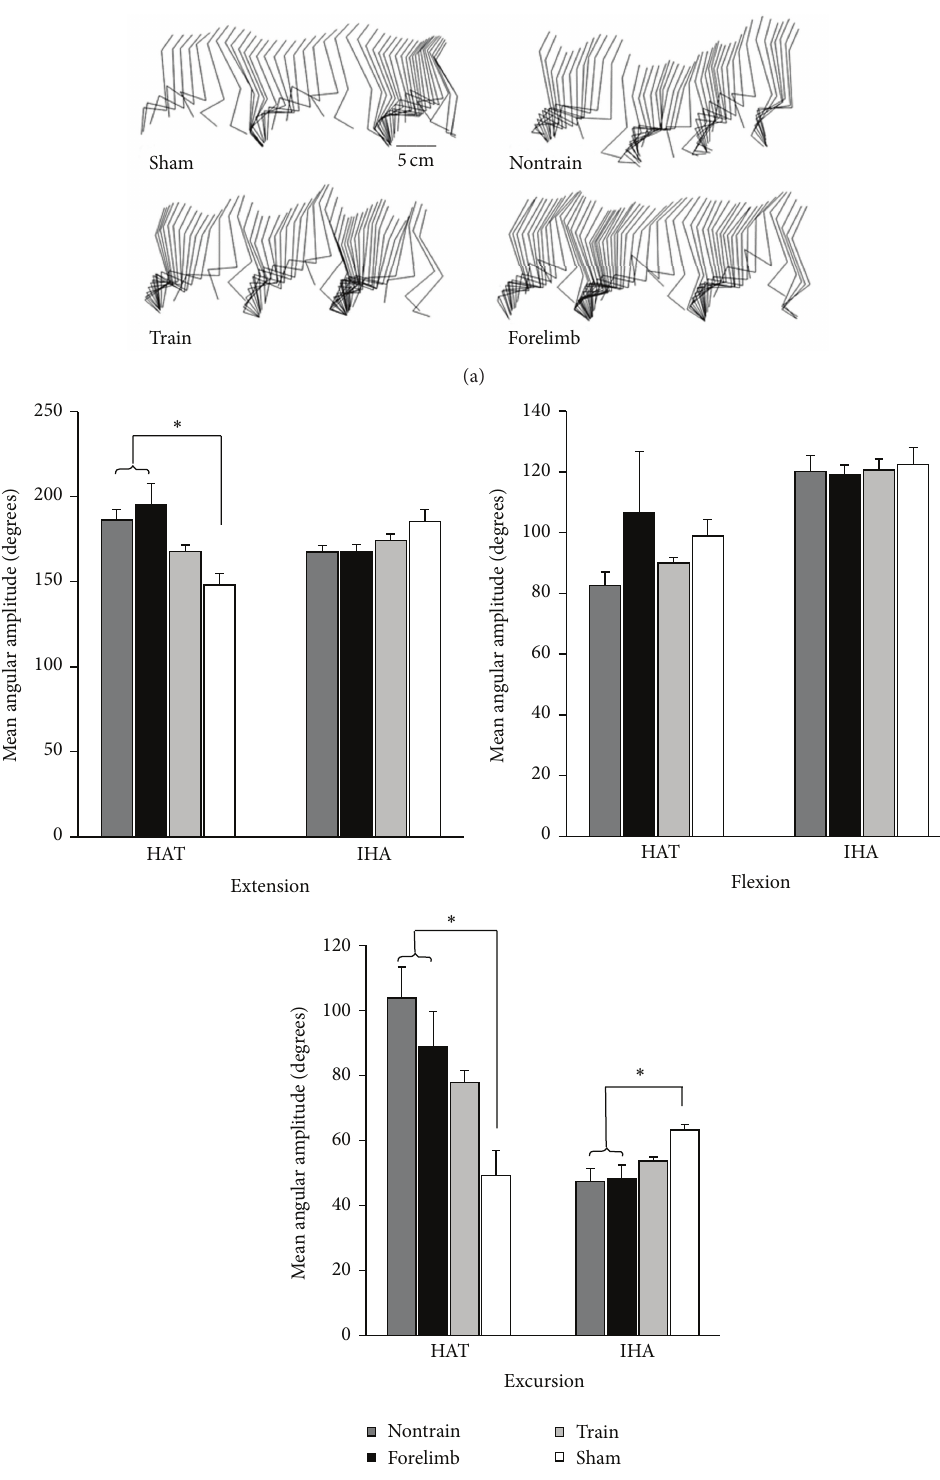
Figure 3: (a) Kinematic illustration of the hindlimb (iliac crest, greater trochanter, knee, lateral malleolus, and metatarsophalangeal joint) during stepping. (b) The maximum (extension) and minimum (flexion) angles as well as excursion (range of motion) of the hip-ankle-toe and iliac crest-hip-ankle angles were calculated and compared between trained ( 𝑛 = 13 ), nontrained ( 𝑛 = 7 ), forelimb ( 𝑛 = 9 ), and sham ( 𝑛 = 4 ) (ANOVA with Bonferroni post hoc 𝑡 -tests). Significant differences were found for ankle extension and hip and ankle excursion ( ∗ sham versus nontrained and forelimb). Sham was not different from